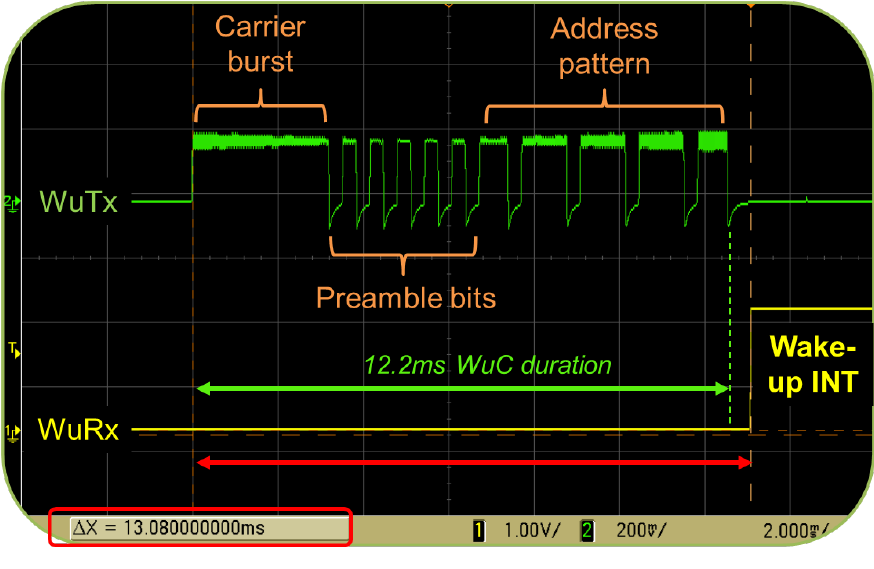
Figure 7. Incoming WuC from the SCM-WuTx and corresponding interrupt (INT) signal generated by the receiving SCM-WuRx to the node’s